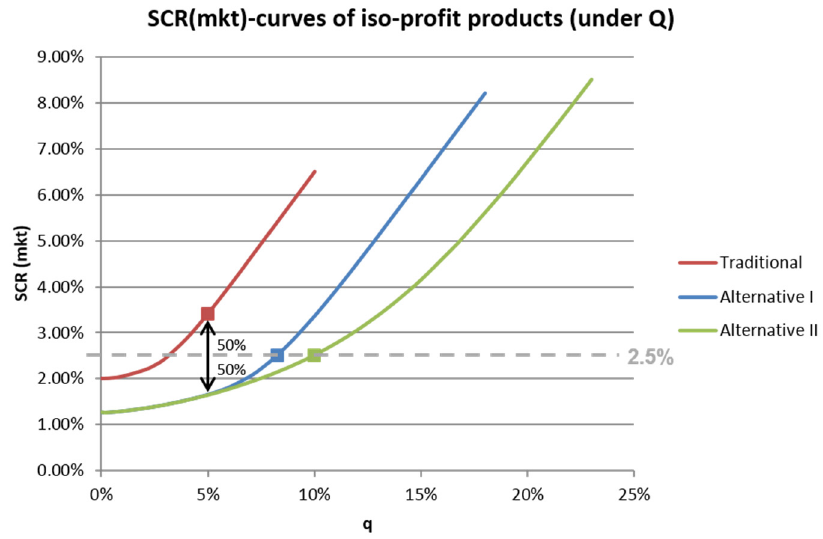
Figure 4. Comparison of products with the same PVFP and reduced SCR mkt , based on the traditional product with q “ 5%